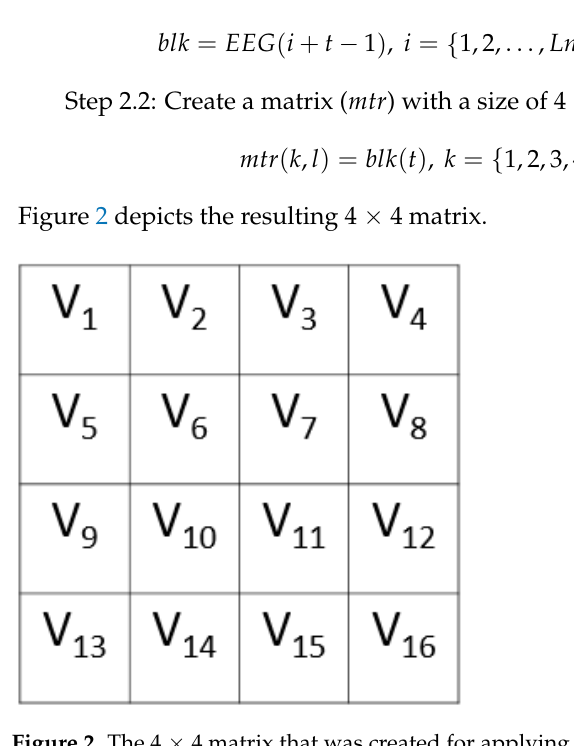
Figure 3. The used L-tetrolet patterns. Each L-tetrolet is named using a letter (e.g., a, b, c, d), and these letters are shown using different colors. These patterns are called P1 and P2. Step 2.4: Extract bits using P1, P2, and binary feature generation function 𝑆(. , . ) . These patterns (P1 and P2) are separately applied to the generated matrix. For P1 and P2, the used a, b, c, and d values are given in Equation (14) according to Figures 2 and 3.